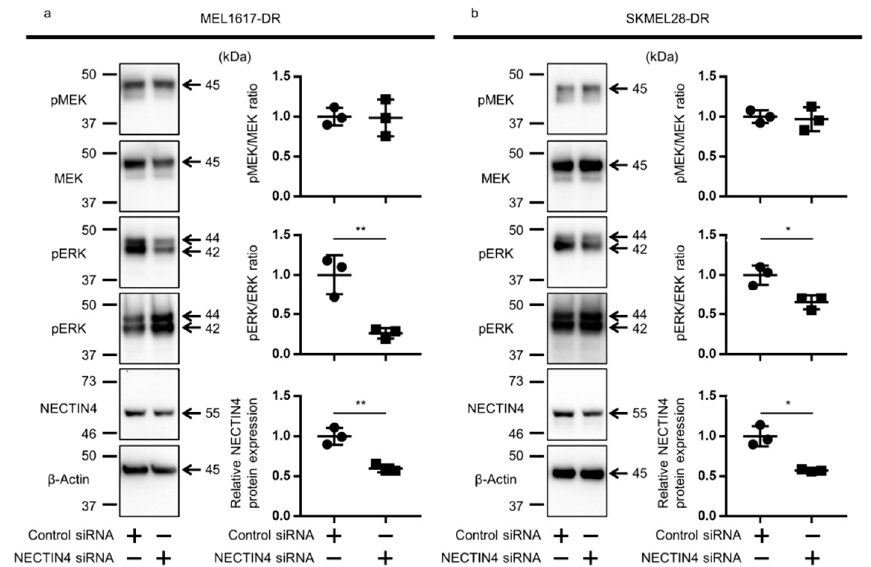
Figure 6. NECTIN4 inhibition downregulates phosphorylated ERK in MEL1617-DR and SKMEL28-DR cell lines. ( a ) MEL1617-DR and ( b ) SKMEL28-DR cell lines were transfected with control or NECTIN4 siRNA and assessed for pMEK/MEK and pERK/ERK ratio. Representative blot images (left panels), and pMEK/MEK ratio, pERK/ERK ratio, and relative NECTIN4 expression (right panels, n = 3) are shown. Data are presented as the mean ± standard deviation of three independent experiments. β -Actin served as a loading control. * p < 0.05 and ** p < 0.01 determined by Student’s unpaired two-tailed t -test.